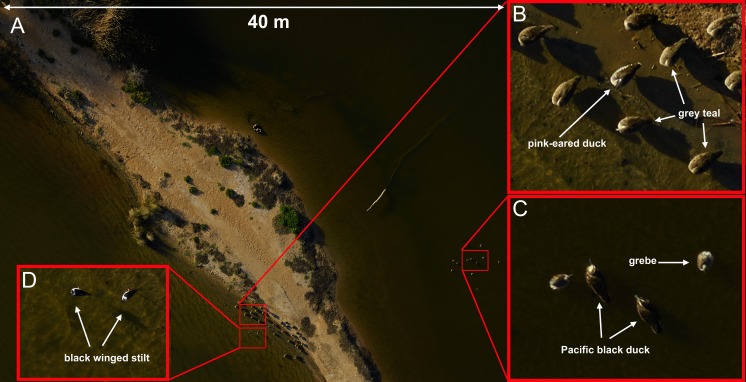
Examples of images taken using the Phase-1 medium format digital camera.Species that are similar in size and shape can be clearly differentiated in photos taken from 60 m above the flock with an 80 mm lens (A and B). Smaller birds such as grebes and black winged stilts can also be easily identified (C and D). A Pacific black duck can be seen tilting its head to look directly up at the camera (C). This image was captured with an ISO = 400, shutter speed = 1/800 s and f-stop = 11. The area footprint of this image is 40 m × 30 m with ground coverage of 5.5 mm/pixel.